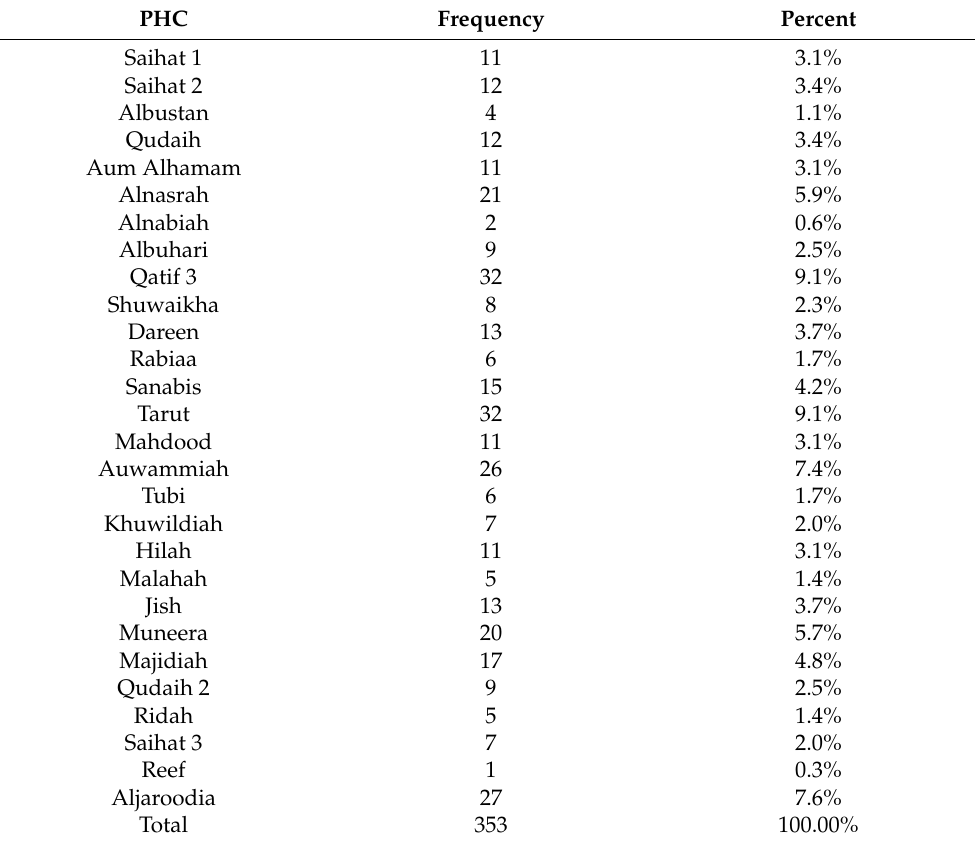
Table 3. Primary Health Care centres with identified study participation